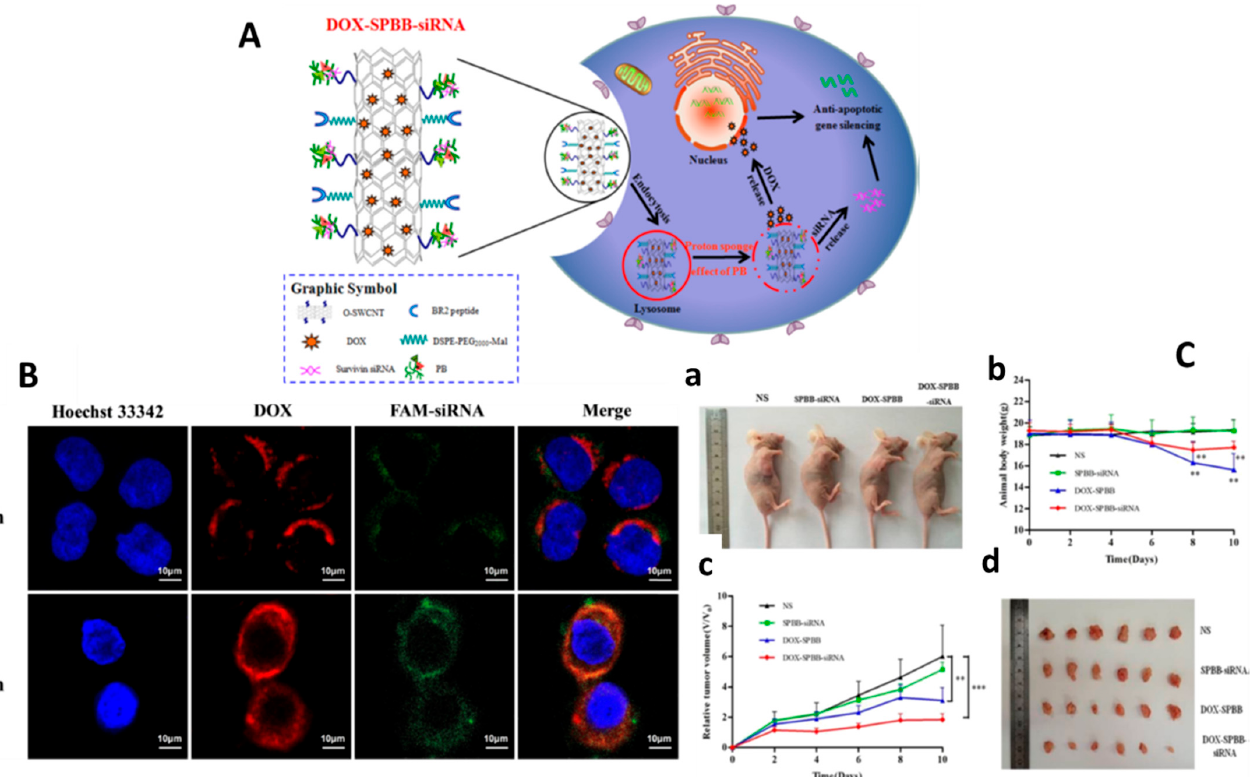
Figure 12. ( A ) Schematic diagram of DOX–SPBB–siRNA nanocarriers in A549 lung cancer cells. ( B ) CLSM images of A549 cells treated with DOX–SPBB–siRNA for 2 and 4 h at given concentrations of DOX (2 μ g/mL) and FAM–siRNA (80 nM). Each column from left to right: nuclei stained with Hoechst 33342 (blue); DOX fluorescence in cells (red); FAM signal in cells (green); DOX and FAM-siRNA merged with nucleus. ( C ) In vivo antitumor ability of SPBB loaded with DTX and/or siRNA in A549 tumor-bearing nude mice. ( a ) Appearance of tumor growth. ( b ) Changes in body weight. ( c ) Changes in relative tumor volumes. ( d ) Tumor tissues after being treated for 10 days (n = 6, mean ± SD). Reprinted with permission from Applied Materials, Copyright 2019, American Chemical Society [93]. ** p < 0.01; *** p < 0.001.